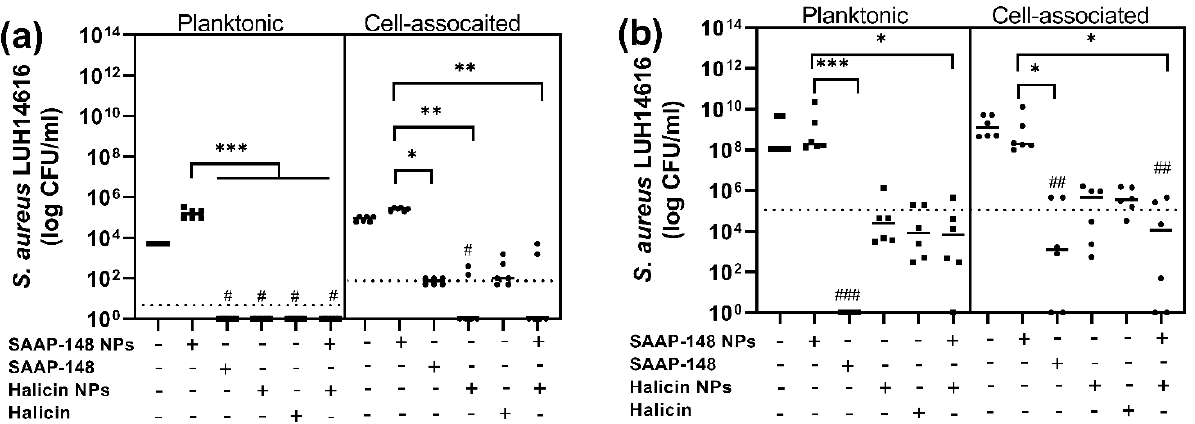
Figure 5. Bactericidal activity against planktonic (squares) and cell-associated (circles) AMR S. aureus in 3D human skin equivalents (HSE) after exposure for ( a ) 4 h and ( b ) 24 h. Data are presented as the median of three independent experiments performed in duplicate. The average bacterial concentration, at which 99.9% of bacteria are killed (LC 99.9 ), is represented by the dashed lined. Statistical significance compared to PBS (negative control) is depicted with a number sign (#) and compared to SAAP-148 NPs is depicted with an asterisk (*) above each data set where a p ≤ 0.05 is considered statistically significant, as calculated by the Kruskal–Wallis test with Dunn’s post-hoc test. Statistical significance between two groups is depicted as */# for p ≤ 0.05, **/## for p ≤ 0.01, or ***/### for p ≤ 0.001. SAAP-148 concentration = 204.8 µ M; halicin concentration = 409.6 µ M.